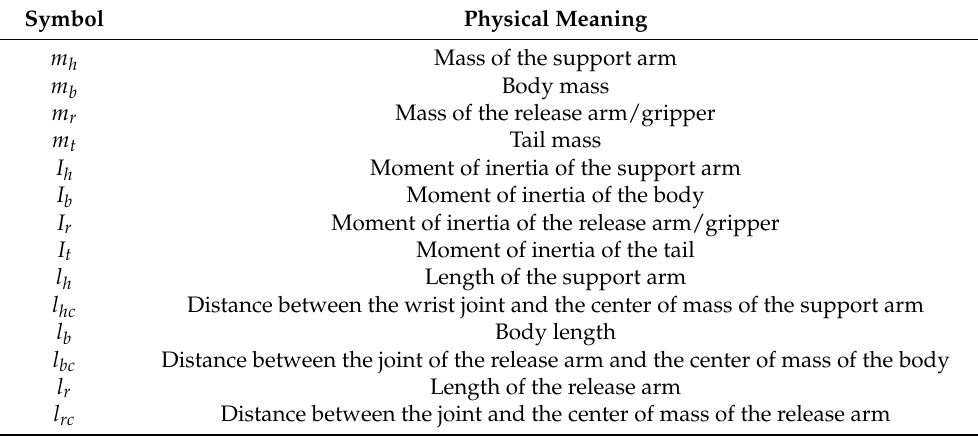
Figure 10. Four-link dynamic model of proposed robot. Table 2. Parameters used in robot model.